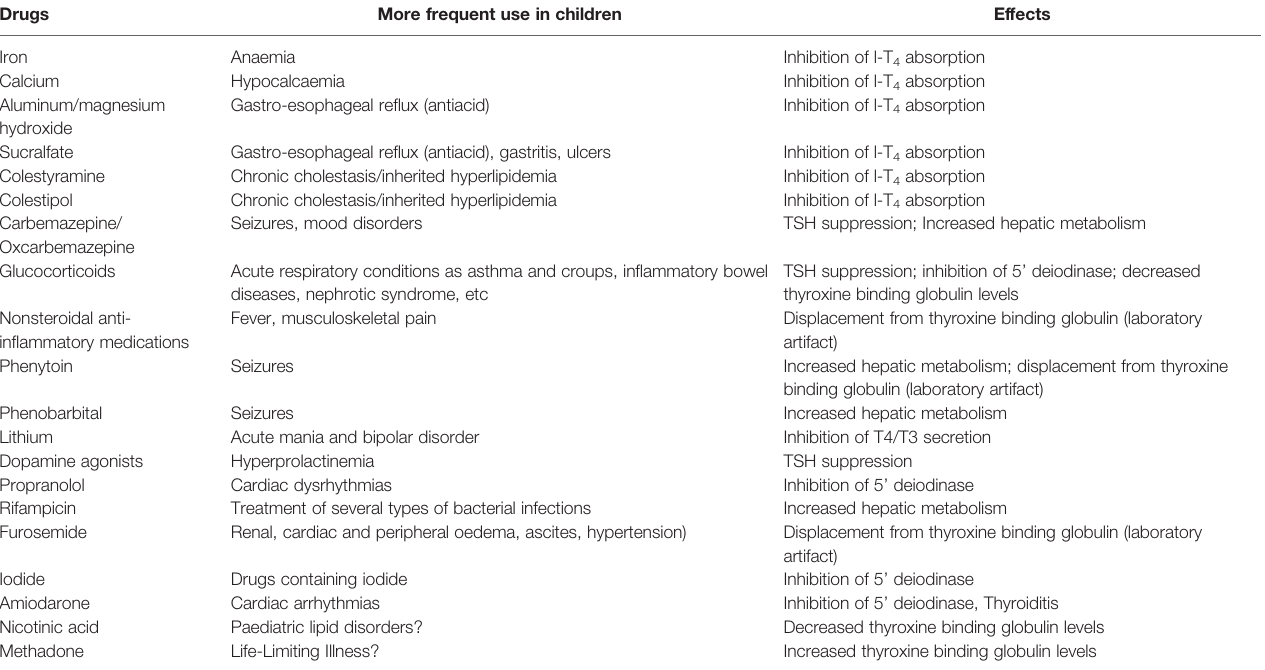
TABLE 2 | Main drugs potentially affecting thyroid function or thyroid hormone levels in patients with congenital hypothyroidism.